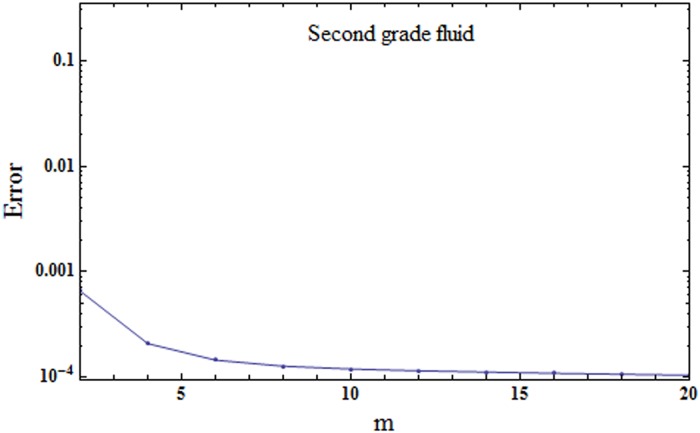
Total residual error for second grade fluid.